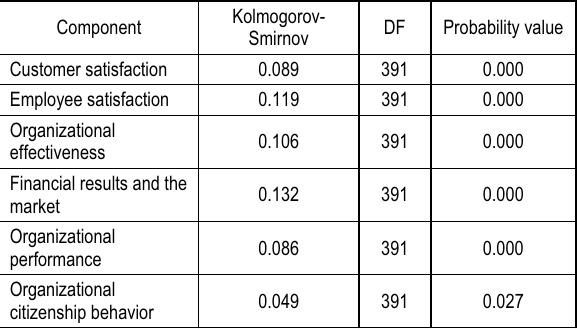
Table 2. Results of Kolmogorov-Smirnov test to for normal distribution of data